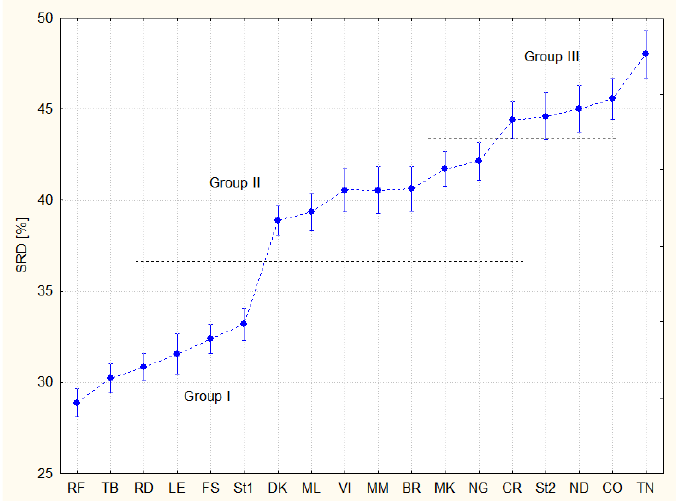
Figure 3. Comparison of experts (F3, Sum of Ranking Differences, SRDs are scaled between 0 and 100). The coding options are amalgamated in F3. The error bars represent 95% confidence interval.